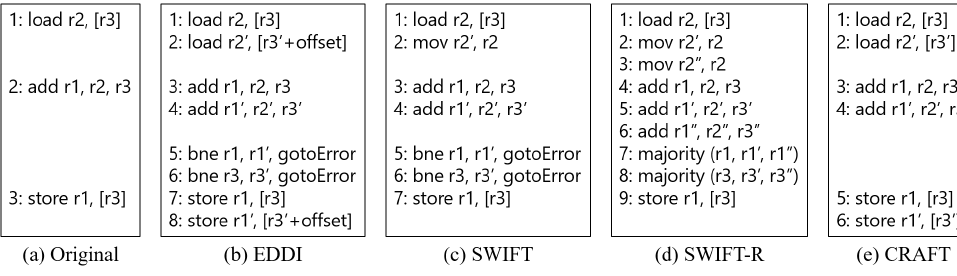
Figure 1. Comparison of instruction stream for several instruction duplication schemes.